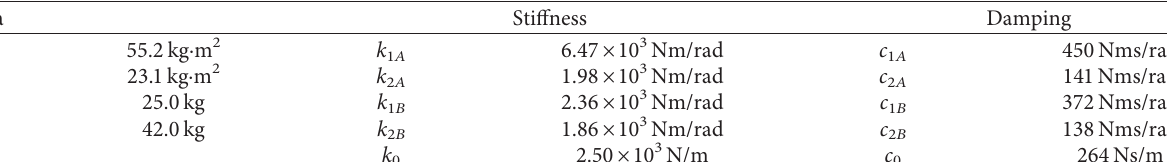
Table 1: Inertia, stiffness, and damping parameters used in the dynamic models. Inertia Stiffness